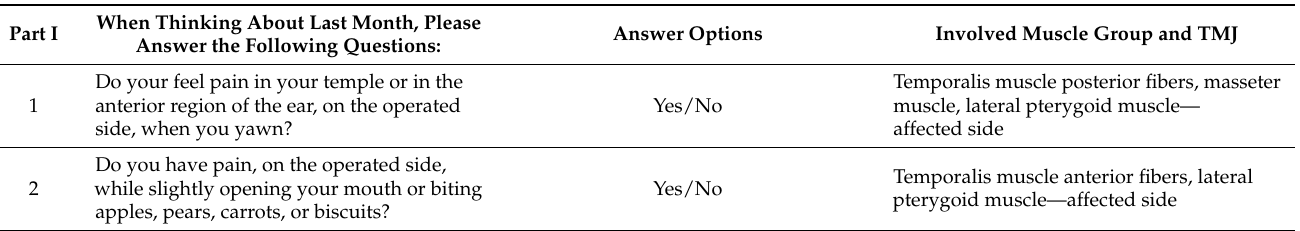
Table 1. Questionnaire Part I for the evaluation of the affected masticatory muscles groups and the temporomandibular joint